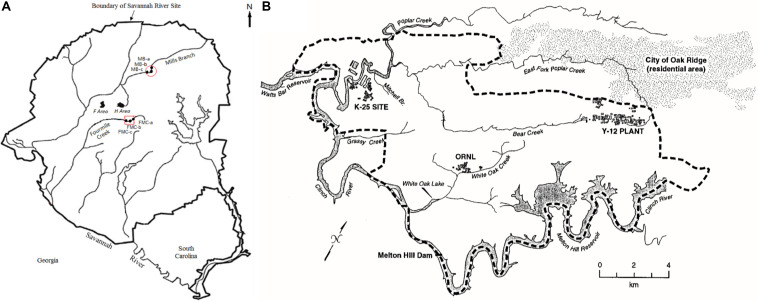
Map of soil sampling locations included in this study. (A) Savannah River Site (SRS), Aiken, South Carolina, and; (B) Oak Ridge Reservation (ORR), Tennessee. Maps shown here have been previously reported by Xu X. et al. (2019) (SRS) and Campbell et al. (1998) (ORR), respectively.